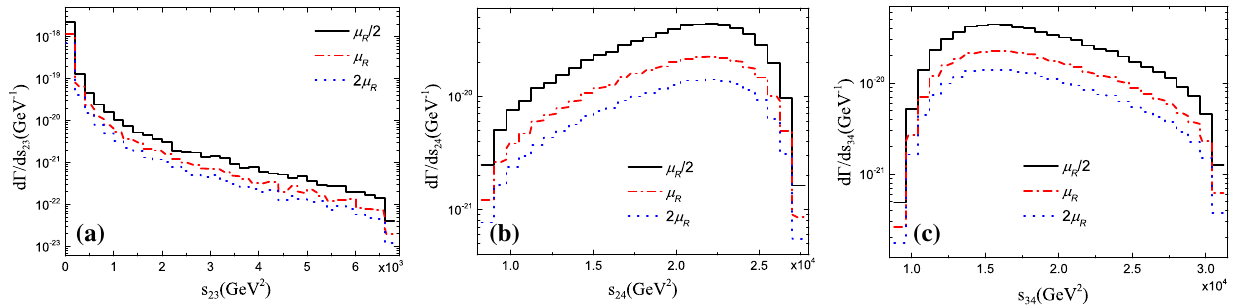
Fig. 4 The differential decay width d (cid:2)/ ds 23 ( a ), d (cid:2)/ ds 24 ( b ) and d (cid:2)/ ds 34 ( c ) with renormalization scale uncertainty for t → | ( c ¯ c ) [ n ](cid:5)+ c + Z 0